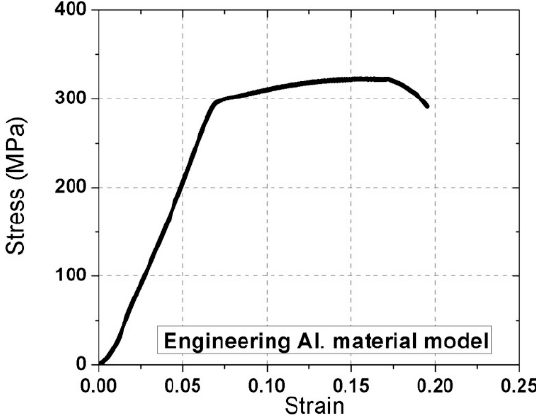
Figure 11. Stress–strain curve of high-strength aluminium 6082-T6 [93]. The different types of materials used in the literature are summarized in Table 5. Table 5. Main types of materials used for bolts in the reviewed literature.